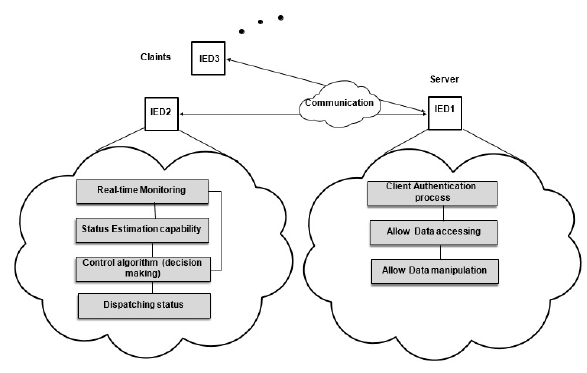
Figure 1: Distributed DMS IEDs overall concept